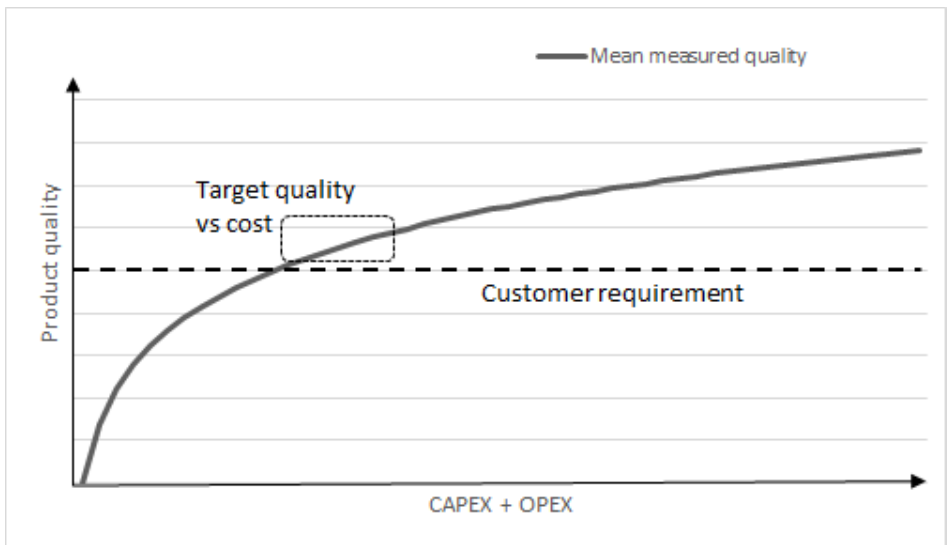
Figure 7. Schematic diagram of how the quality, theoretically, can be seen to relate to investments into new machinery and increased operational support (CAPEX and